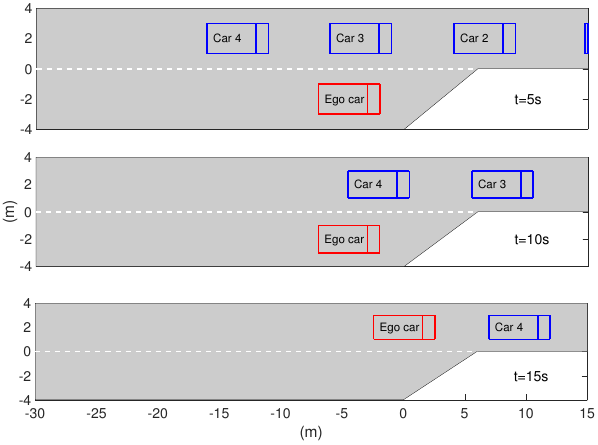
Figure 7. Scenario 3: p i = { 0.9,0.1,0.1,0.1 } .